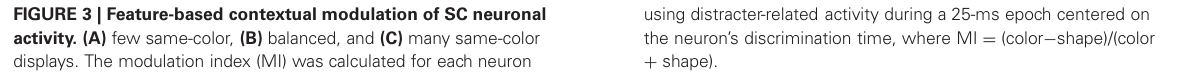
using distracter-related activity during a 25-ms epoch centered on the neuron’s discrimination time, where MI = (color − shape)/(color +